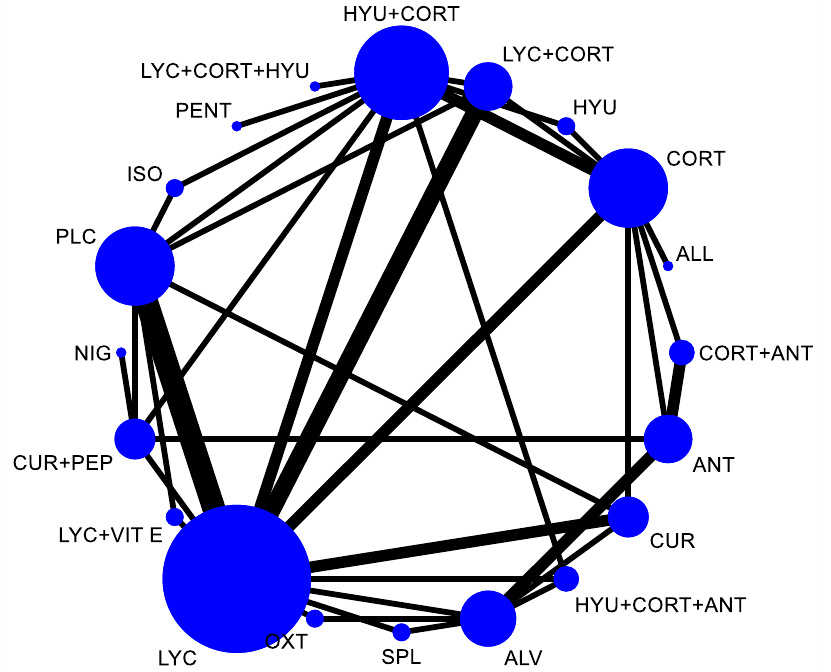
Figure 2. Network plot comparing the comparative efficacy of interventions used in the management of OSMF (mouth opening). Abbreviations: HYU—hyaluronidase; CORT—corticosteroid; LYC—lycopene; ALL—allicin; ANT—antioxidant; CUR—curcumin; ALV—aloe vera; SPL—Spirullina; OXT—Oxitard; VIT E—vitamin E; PEP—piperine; NIG—Nigella sativa; PLC—placebo; ISO—isoxsuprine; PENT — pentoxifylline.